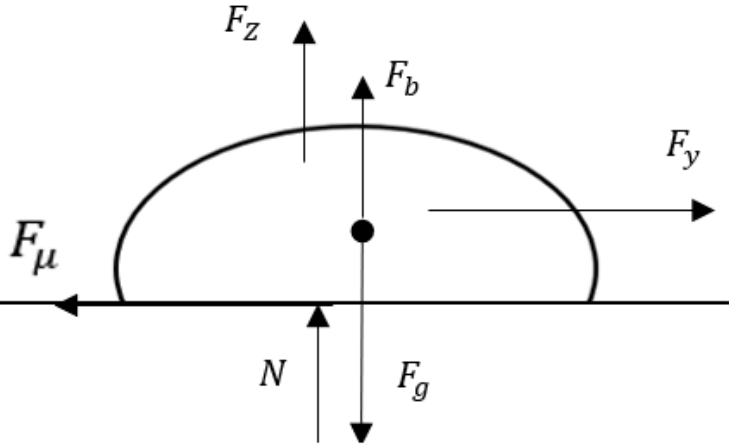
Figure 4. The loads applied to the submerged Geotube.